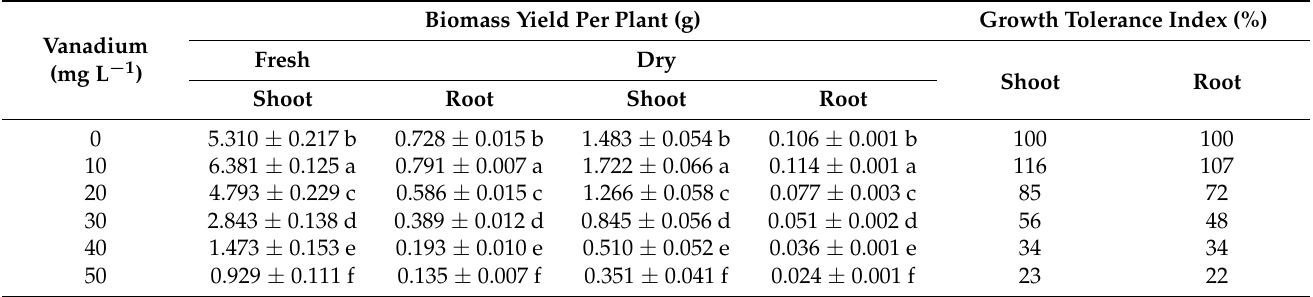
Table 1. Effect of vanadium on fresh and dry biomass of pepper seedlings.